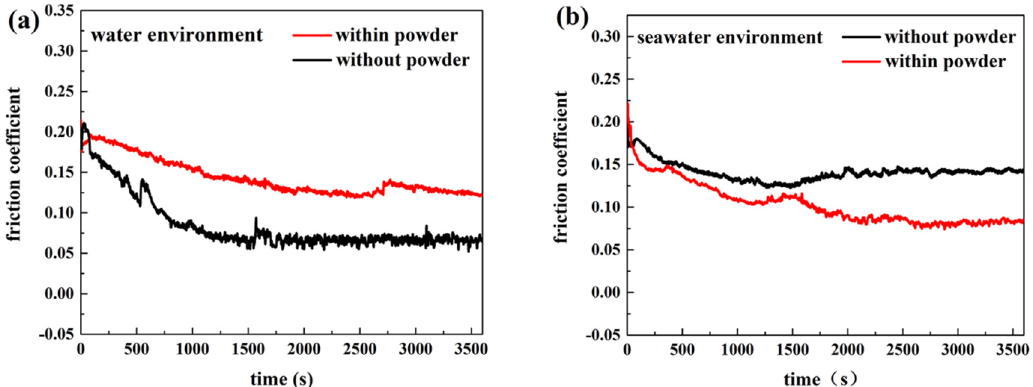
Figure 9. The friction coefficient of PA66 pin in ( a ) water and ( b ) seawater environments.